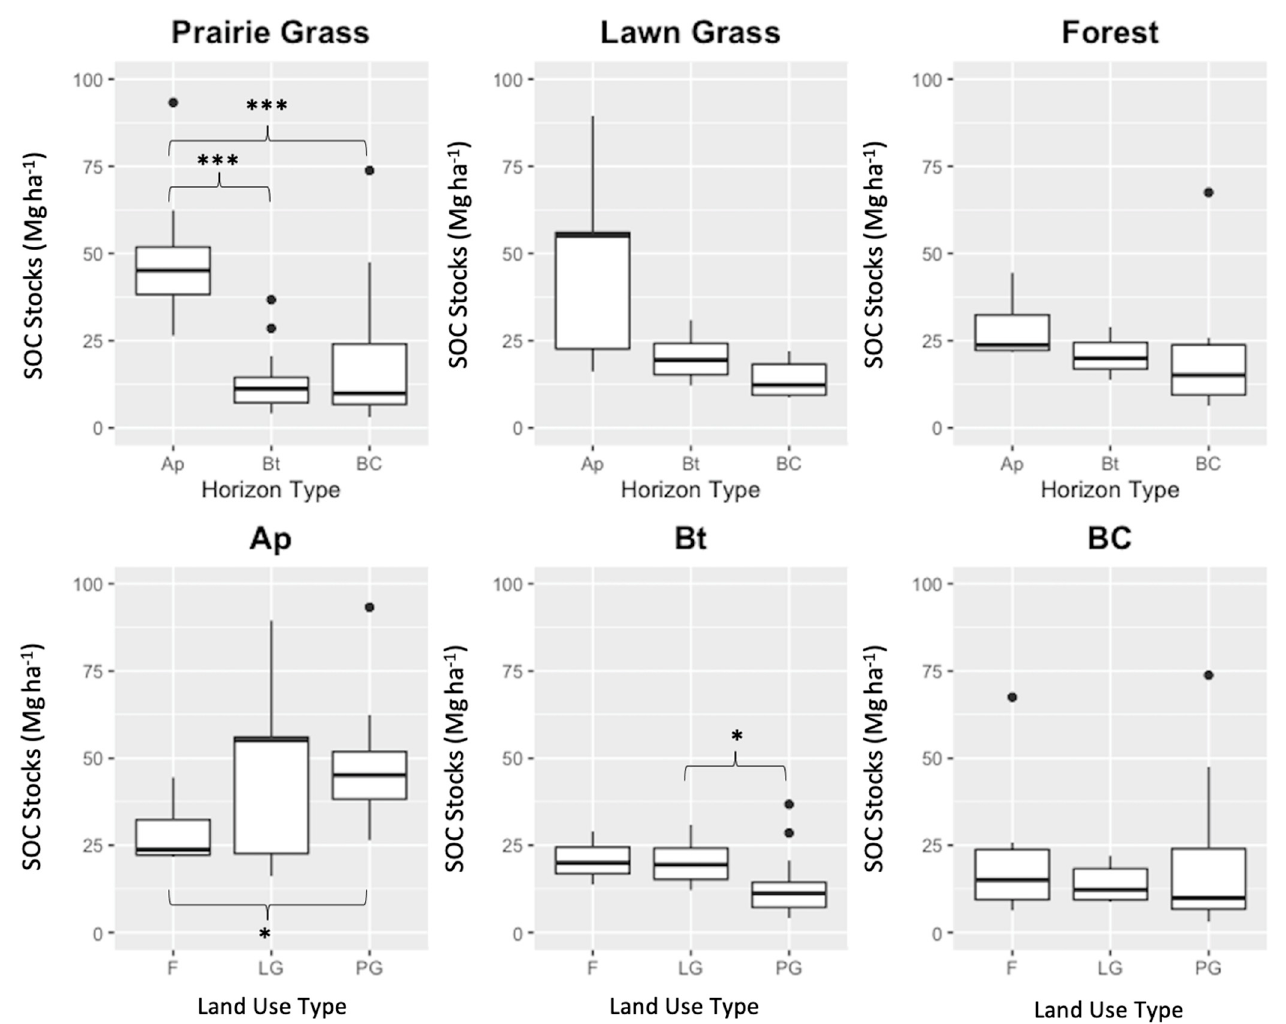
Figure 5. Box plots of mean SOC stock statistical comparisons by land use and soil horizons. Three stars indicate significance at p < 0.001 and one star indicates significance at p < 0.05. black dots represent 5th and 95th percentile values.